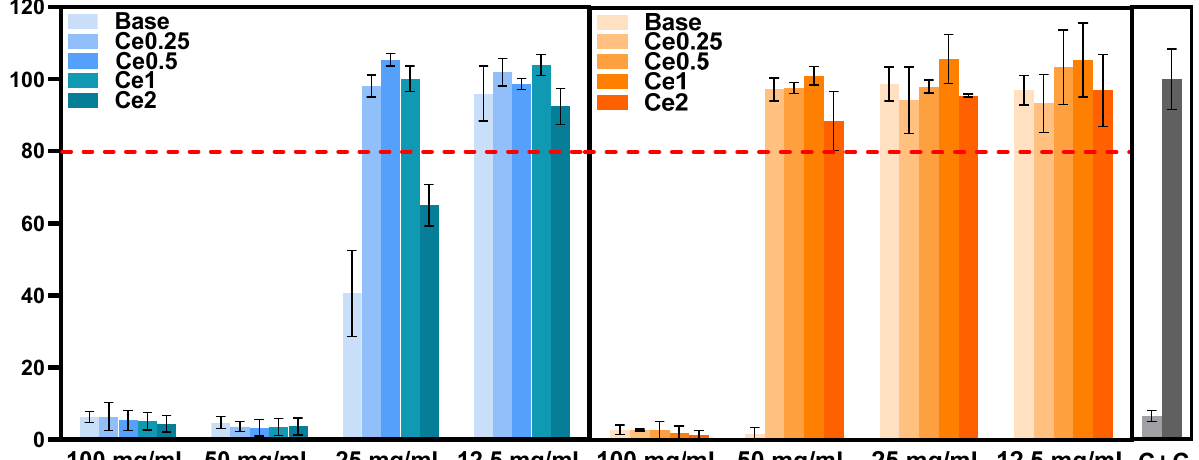
Figure 2. Relative cell viability of Saos-2 cells after 48 h incubation with glass extracts ( left side: non-passivated extracts; right side: passivated extracts).